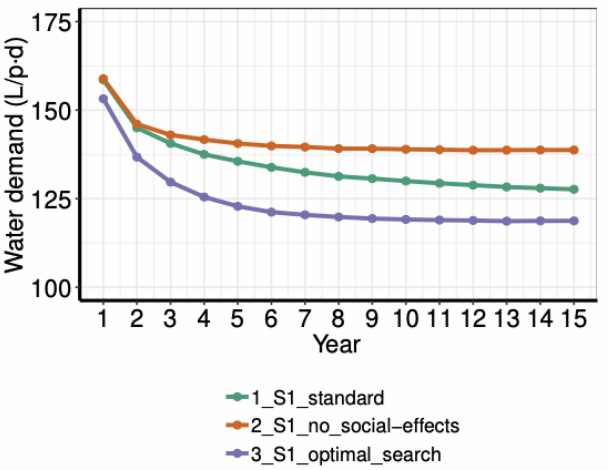
Figure 6. Simulated average water use for variations of the scenario S1. Water use per capita decreases over time for all the three scenario variations. Results show that social effects contribute to reduce the water use. Likewise, if households are competent when searching for new practices and technologies to save water, water use decreases rapidly.